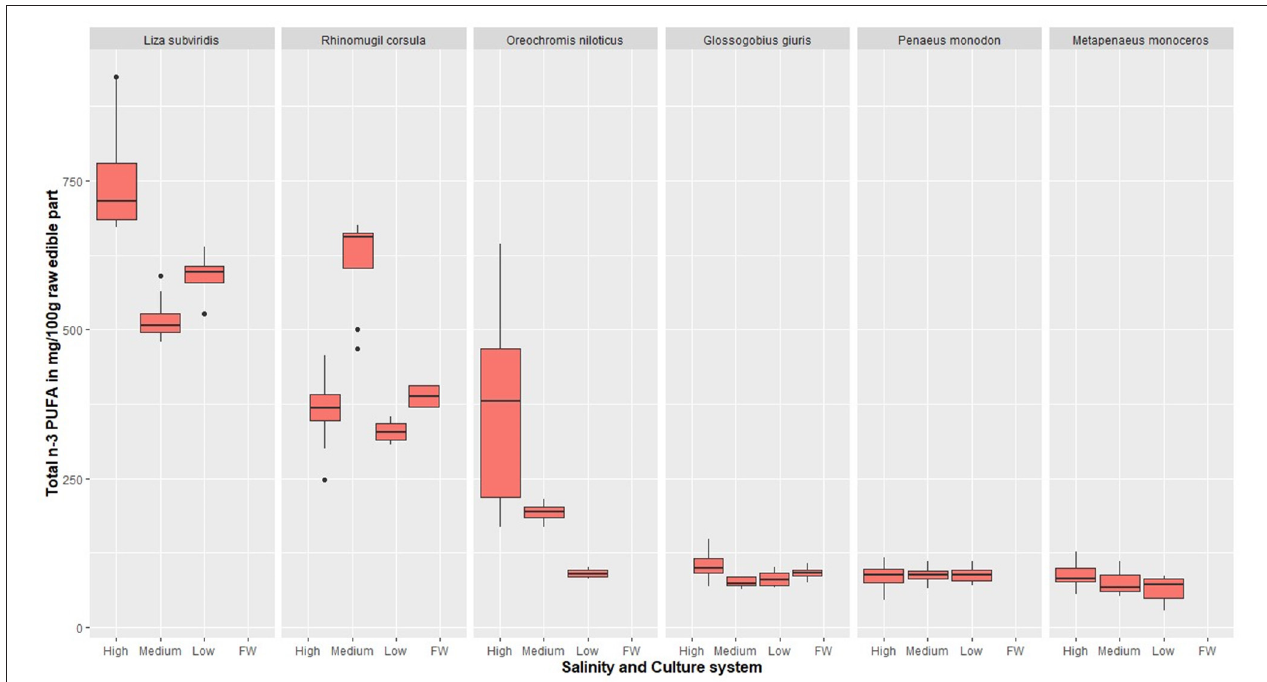
FIGURE 2 | Levels of total n-3 LC-PUFA (mg/100g raw edible part, mena values; error bars show SD) measured in six fish species found across the range of culture systems and salinity regimes in SW Bangladesh.